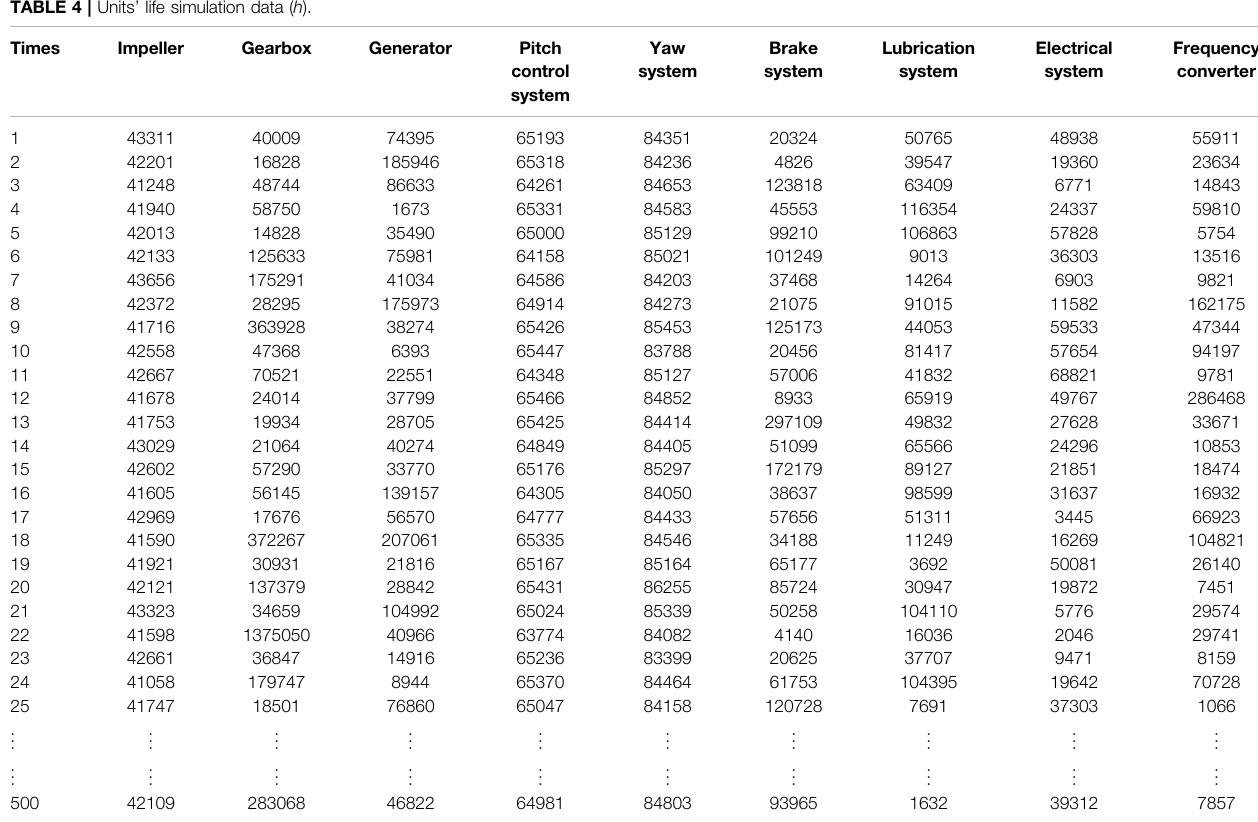
TABLE 4 | Units ’ life simulation data ( h ).